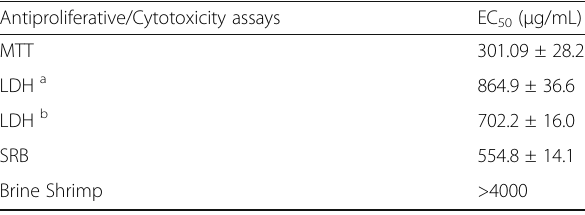
Table 1 The EC 50 values for antiproliferative assays after 24 hour exposure of Semecarpus parvifolia Thw Antiproliferative/Cytotoxicity